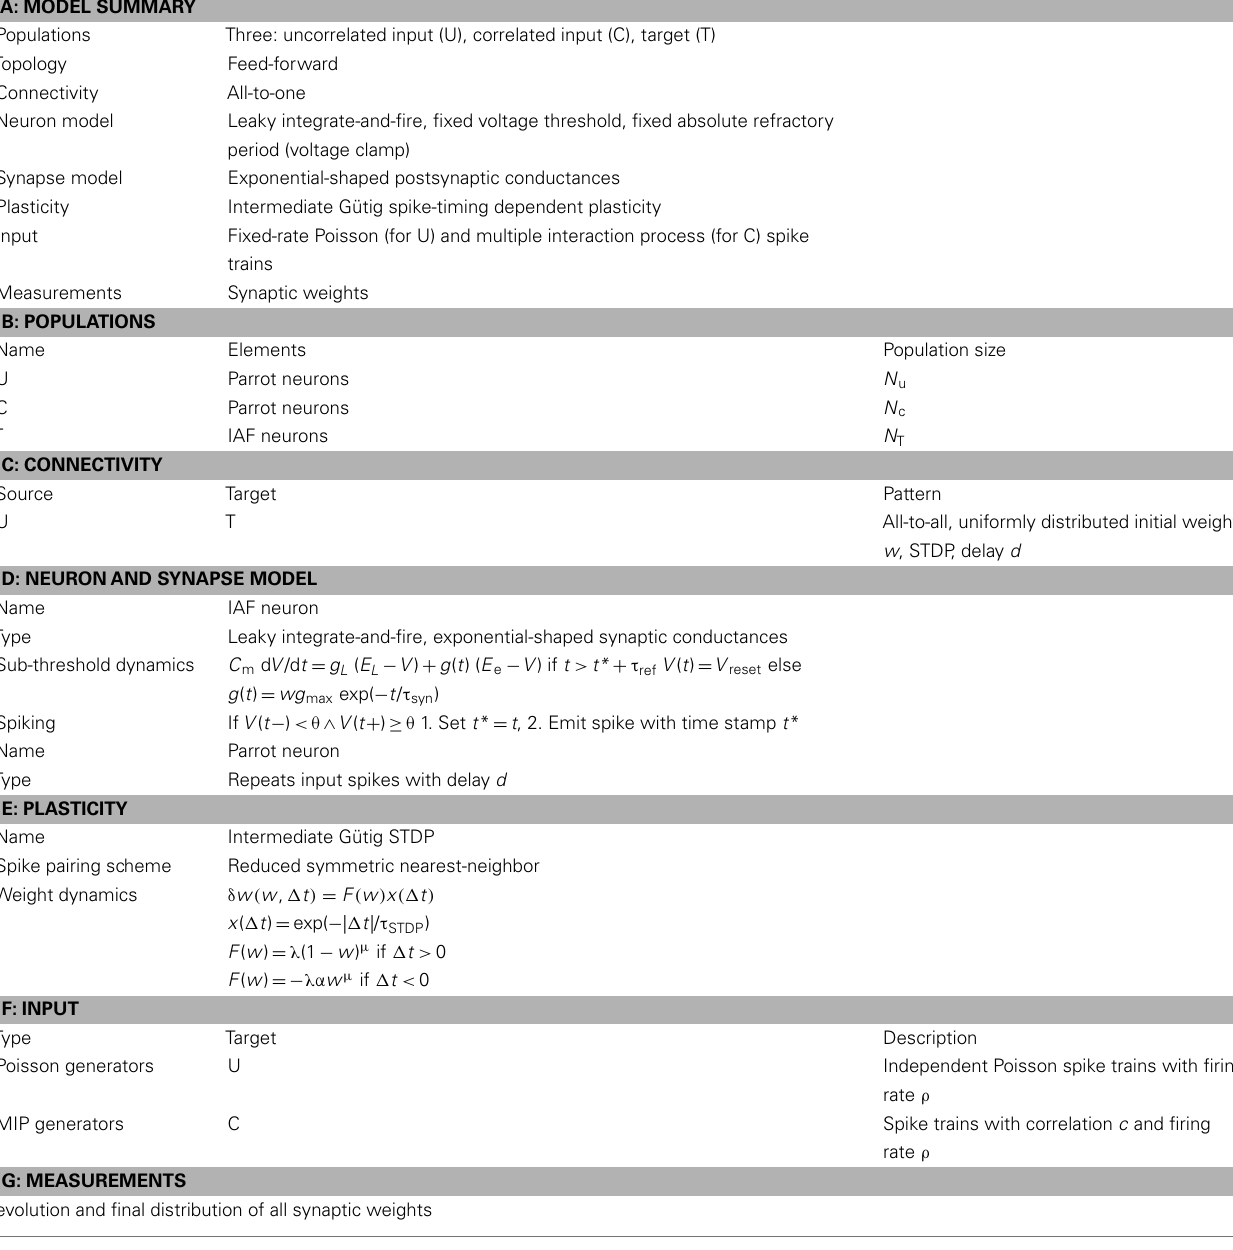
Table 7 | Model description of the network benchmark using the reference synapse model. After Nordlie et al. (2009). A: MODEL